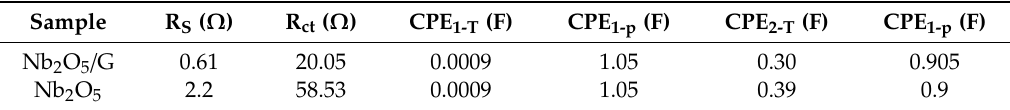
Figure 13. The complex impedance (Nyquist plots) of prepared Nb 2 O 5 and Nb 2 O 5 / G composite electrodes. Inset shows the corresponding equivalent circuit. Table 2. Calculated values of R S , R ct , CPE 1 and CPE 2 through fitting of the experimental impedance spectra based on the equivalent circuit in Figure